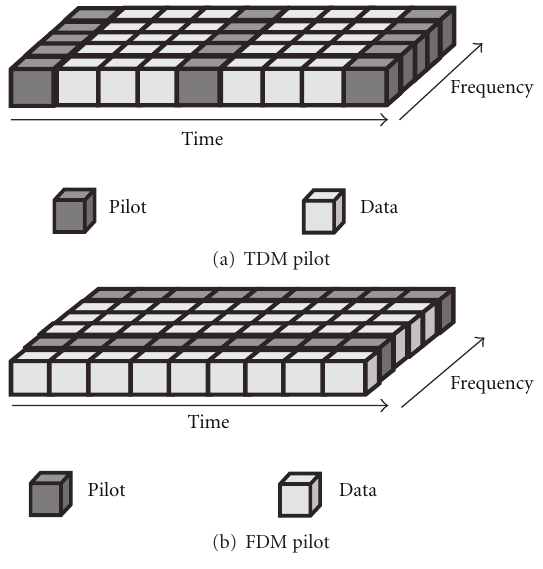
Figure 4: Pilot arrangements.